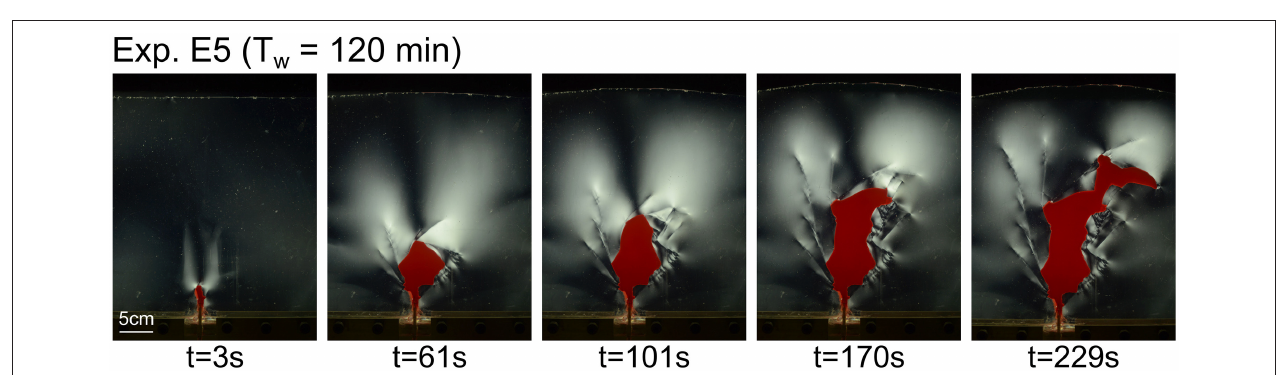
FIGURE 8 | Time series of polarized light photographs of Experiment E5 ( T w = 120 min).